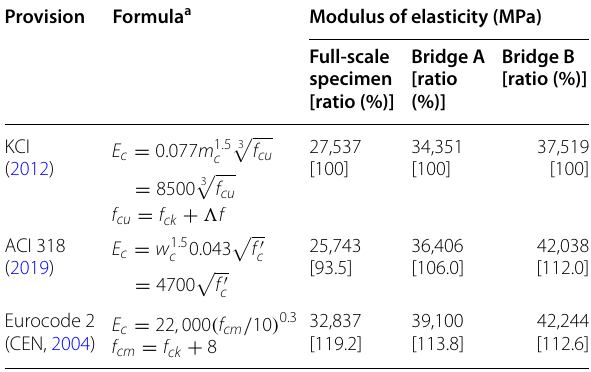
Table 7 Comparison of the modulus of elasticity of concrete.